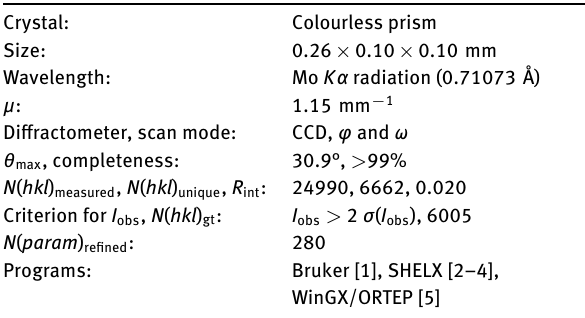
Table 1: Data collection and